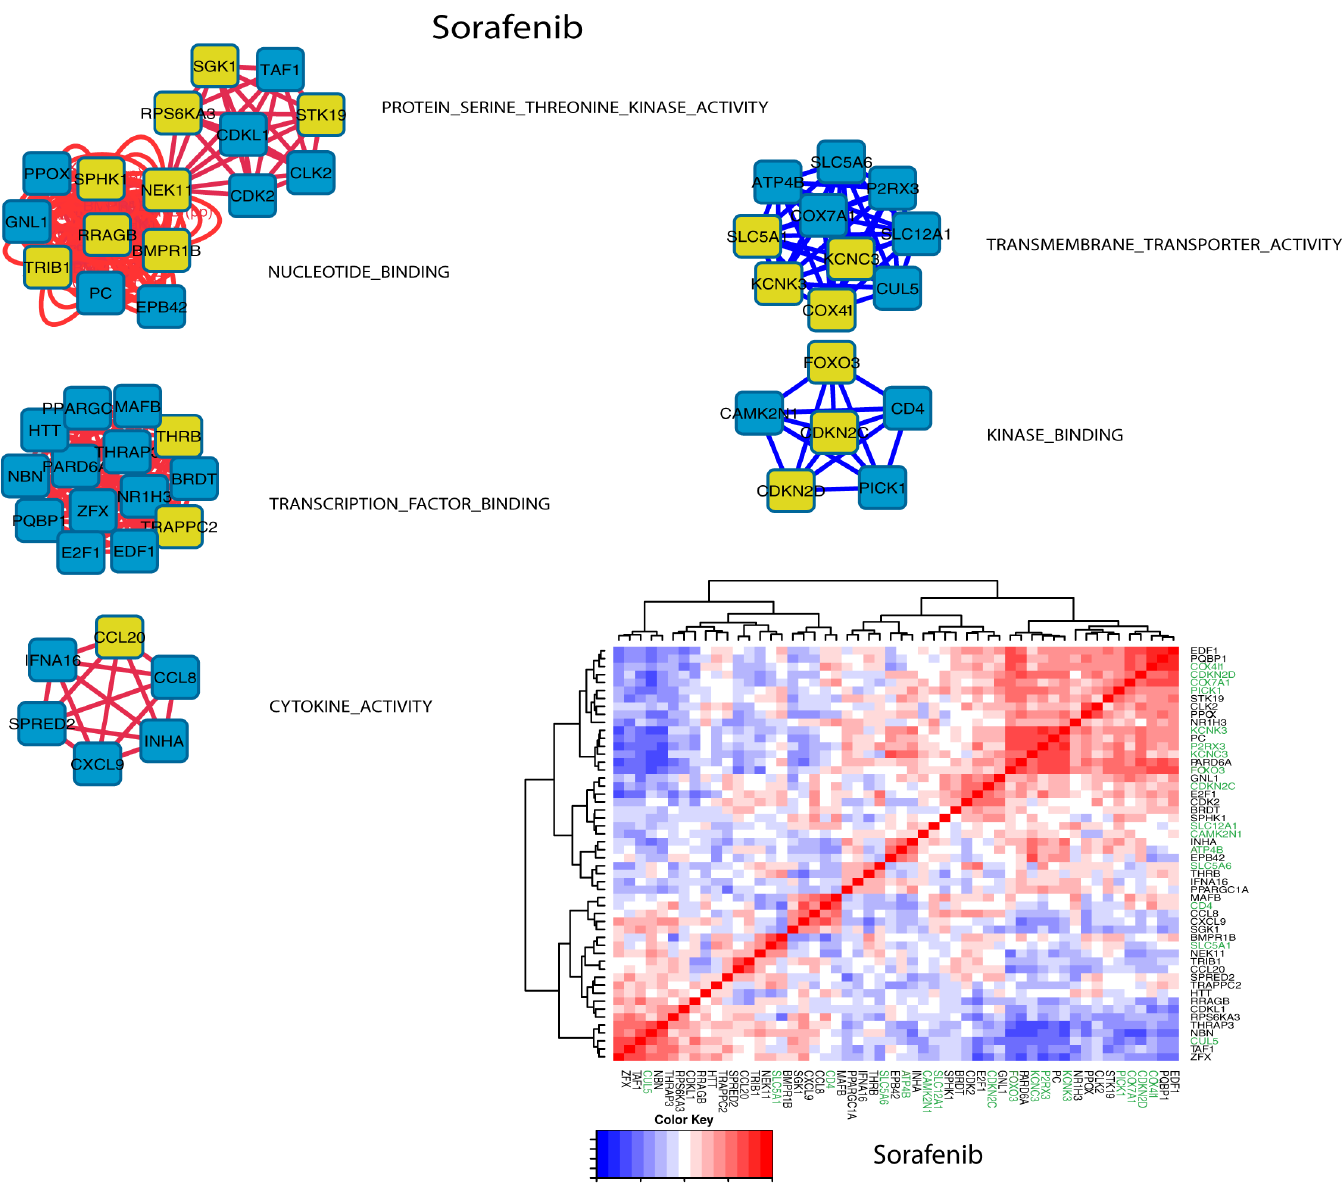
Fig 11. Cytoscape network diagrams using pathway fitness scores as edge weights between pairwise pathway genes (nodes). Results display networks for the upper and lower 20 th percentilesof fitness scores. For displaypurposes,meta-pathways labels, representing abbreviationsfrom those shown in Fig 7 , are used. Six meta-pathways, comprising52 genes, are identifiedfor the GSEA genes analyzed.Node edgesare coloredto indicate relative gene expressions betweenresponderand non-responder groups(red: relative over expression, blue: relative under expression). Nodes for genes derived from pathway fitness are shown in yellow. The full pathwaynames for the meta-pathway labels are: